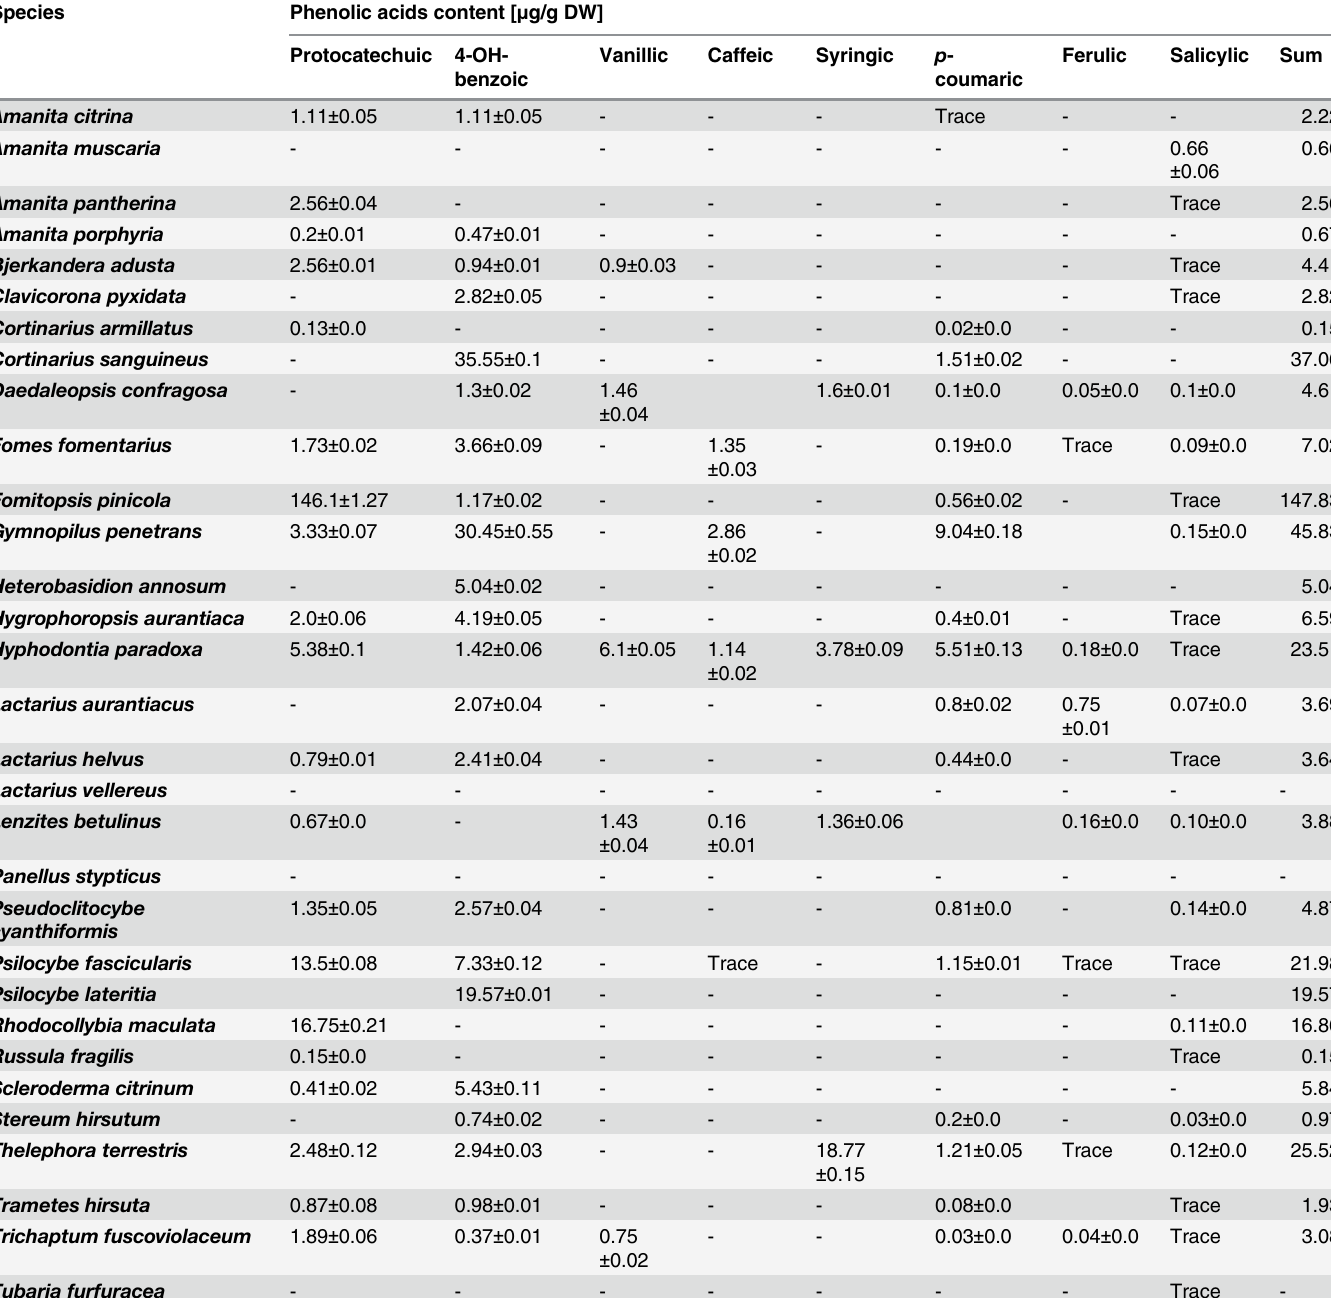
Table 4. Phenolic acid contents in mushroom extracts expressed in μ g per g of dry weight of mushrooms. Abbreviations: “ - ” not detected; Trace — trace amounts. Mean values of three replicate assays with standard deviation.